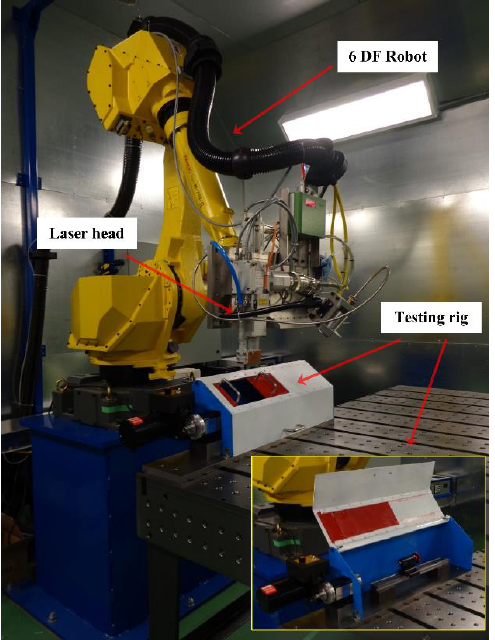
Figure 2. Experimental set-up equipped with a robotic laser cell [21].